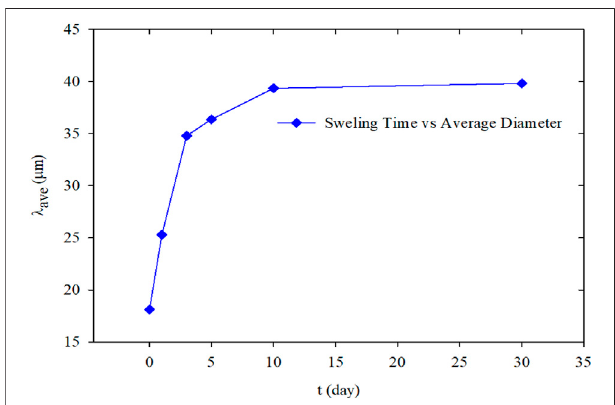
FIGURE 8 | The average size of PMs versus hydration time.